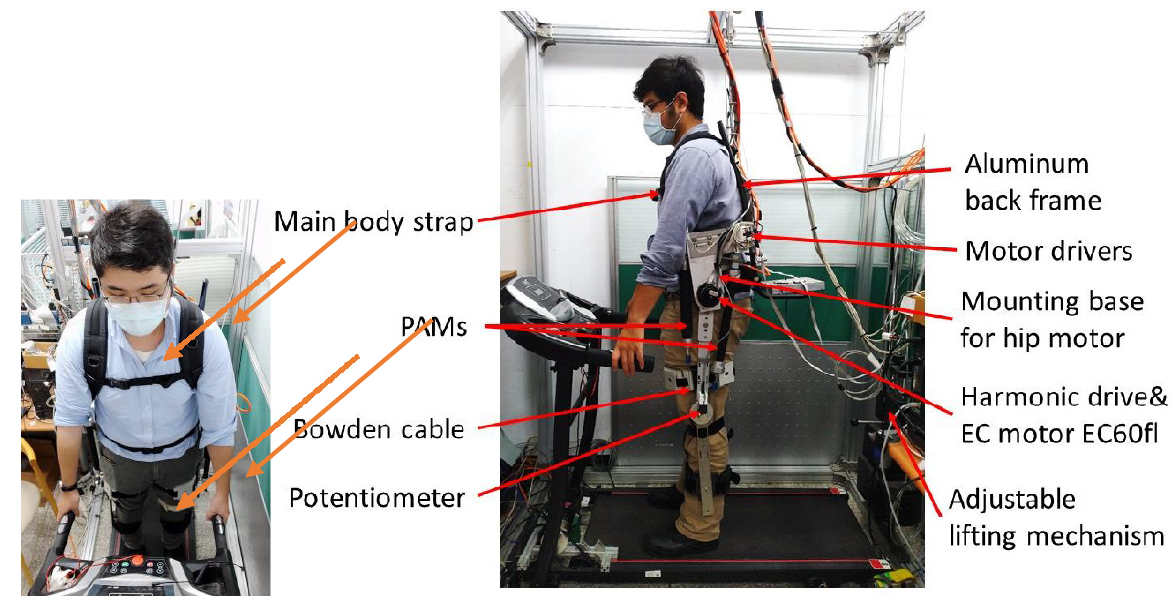
Figure 1. Overview of the lower-limb rehabilitation system.